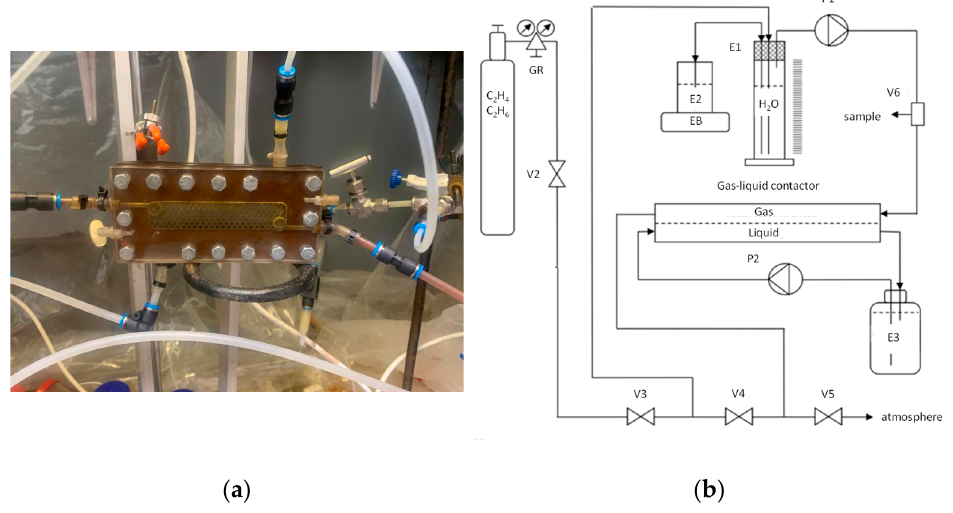
Figure 2. General view of a flat-frame membrane gas-liquid contactor ( a ) and overall scheme ( b